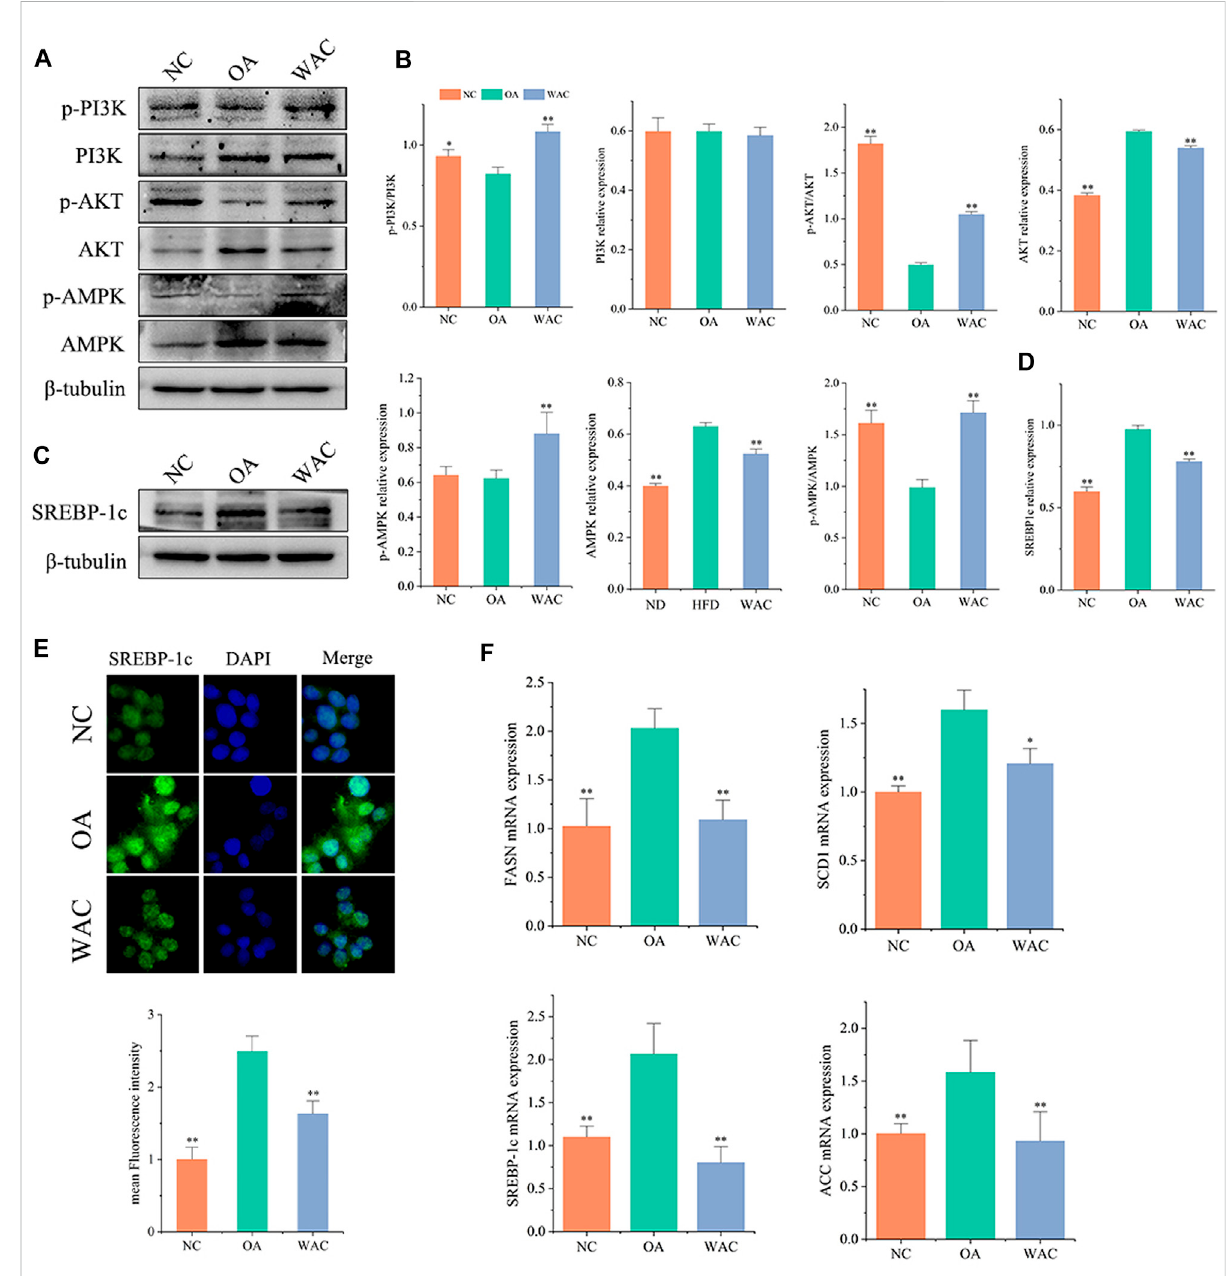
FIGURE 6 Effect of WAC on OA-induced PI3K, AKT, AMPK phosphorylation and SREBP-1c protein expression in HepG2 cells. (A,B) Phosphorylation of PI3K, AKT, AMPK and total protein levels in HepG2 cells. (C,D) Protein levels of SREBP-1c in HepG2 cells. (E) Graph of SREBP-1c immuno fl uorescence results. (F) mRNA levels of FASN, ACC, SREBP-1c and SCD-1 in HepG2 cells. Compared with OA, * indicates p < 0.05 and ** indicates p <